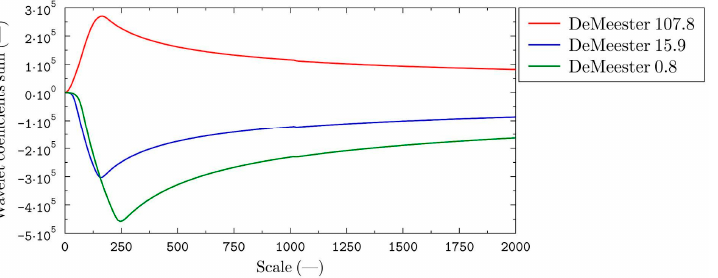
Figure 6. Curves representing sums of wavelet coefficients. Each curve was obtained as a result of summing up wavelet coefficients after the application of the continuous wavelet transform of pH signals for a selected patient during 24 h of measurement procedure. Different colours indicate marginal cases of calculated DeMeester score: blue line—base line (DeMeester 15.9); red—a patient diagnosed with reflux (DeMeester 107.8); green line—healthy patient (DeMeester 0.8).